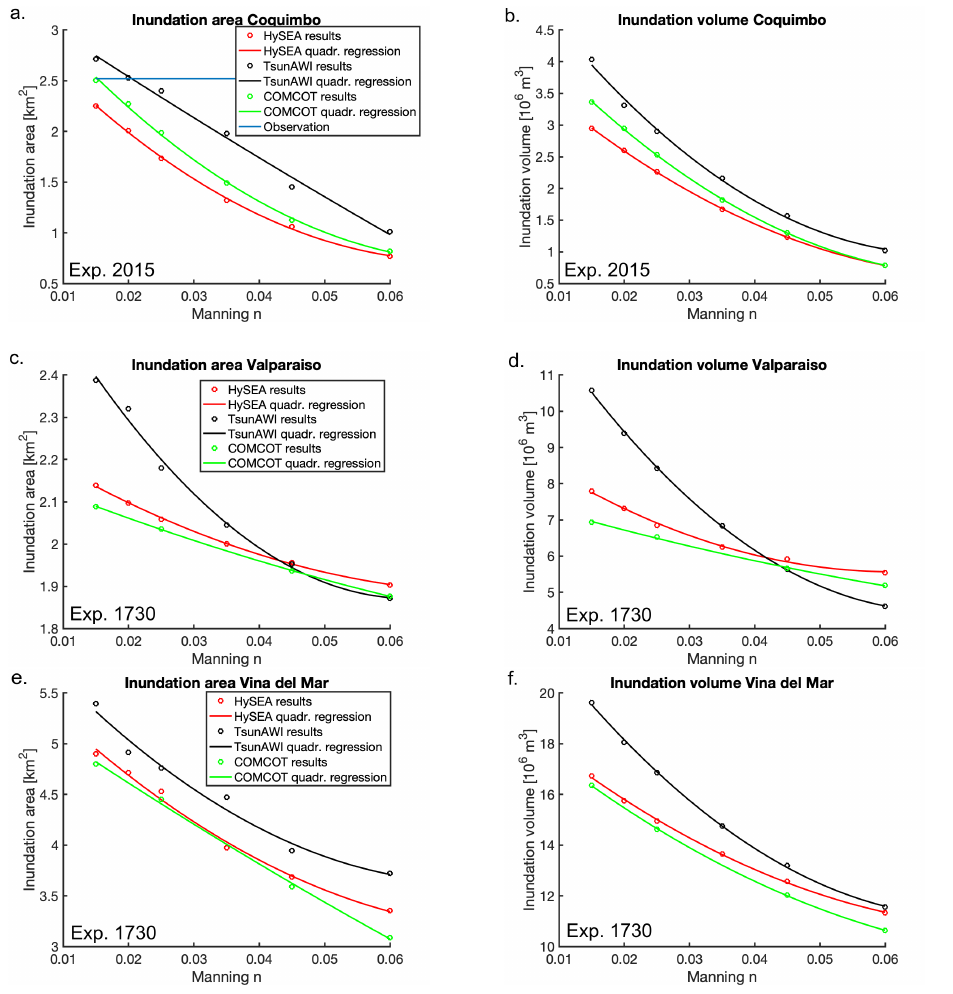
Figure 9. Comparisons of the areas and volumes that resulted from the three numerical models based on Experiments 2015 and 1730. ( a ). Inundation area in Coquimbo from Experiment 2015. ( b ). Volume estimates obtained by integrating the maximum flow depth for Experiment 2015. ( c ). Model results for the inundation area in Experiment 1730 in Valparaíso. ( d ). Volume estimates for Experiment 1730 in Valparaíso. ( e ). Model results for the inundation area in Experiment 1730 in Viña del Mar. ( f ). Volume estimates for Experiment 1730 in Viña del Mar, obtained by integrating the maximum flow depth. The lines are quadratic regressions obtained for least squares